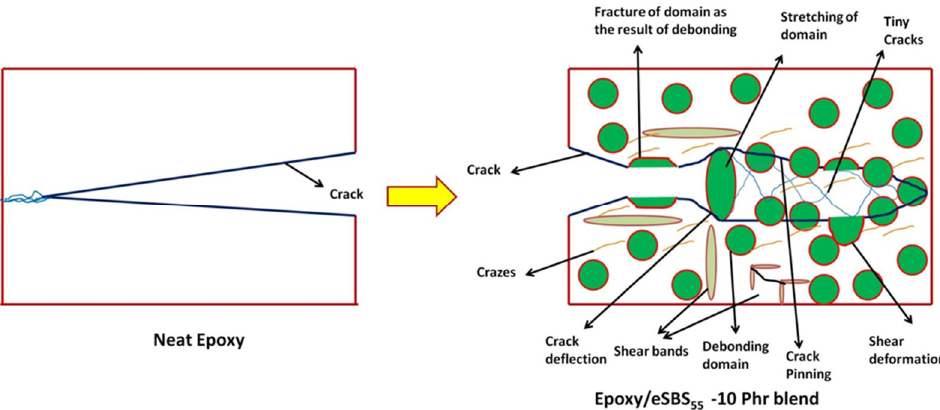
Table 1. Impact strength and impact energy values of neat epoxy and epoxy/eSBS blends.